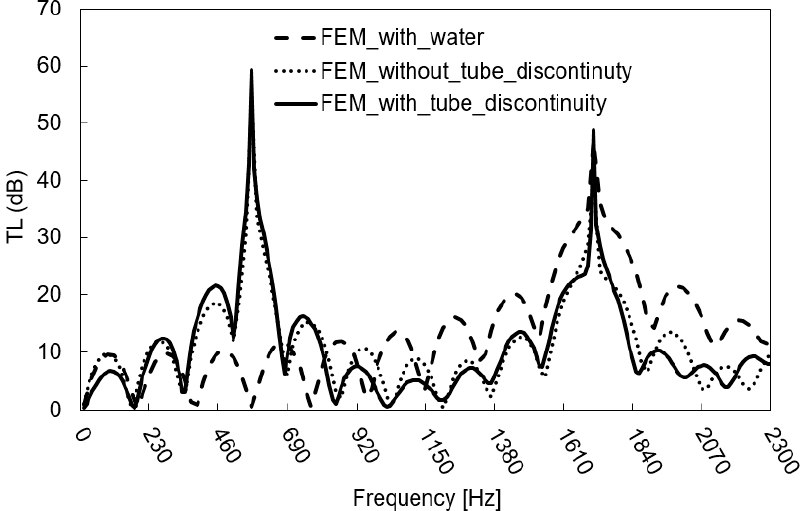
Figure 14. Comparison between experimental and FEM-simulated TL of the model-scale scrubber with and without discontinuity and with Table 8. Comparison between experimental and FEM amplitudes of model-scale scrubber with dis- continuity.